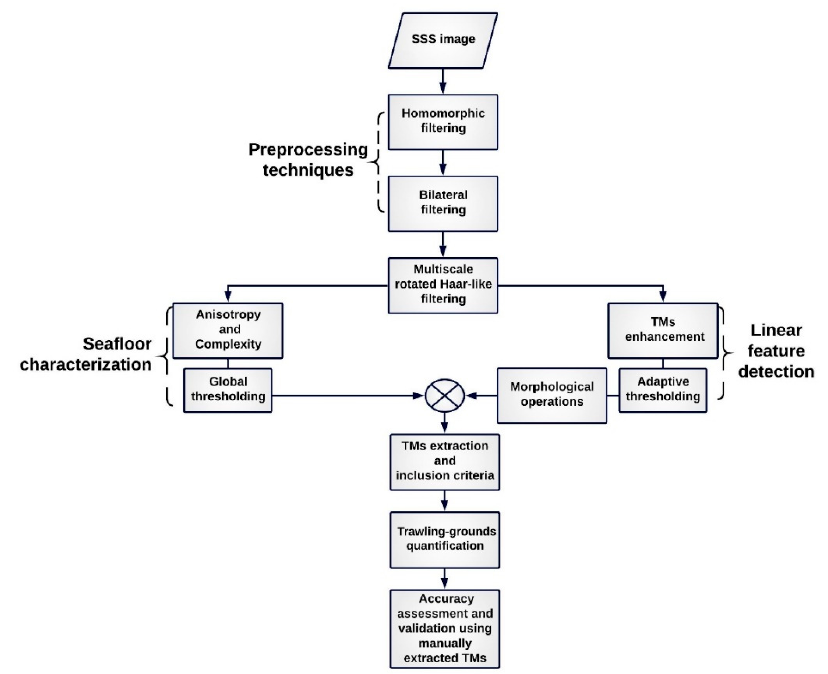
Figure 3. Overall methodology workflow.